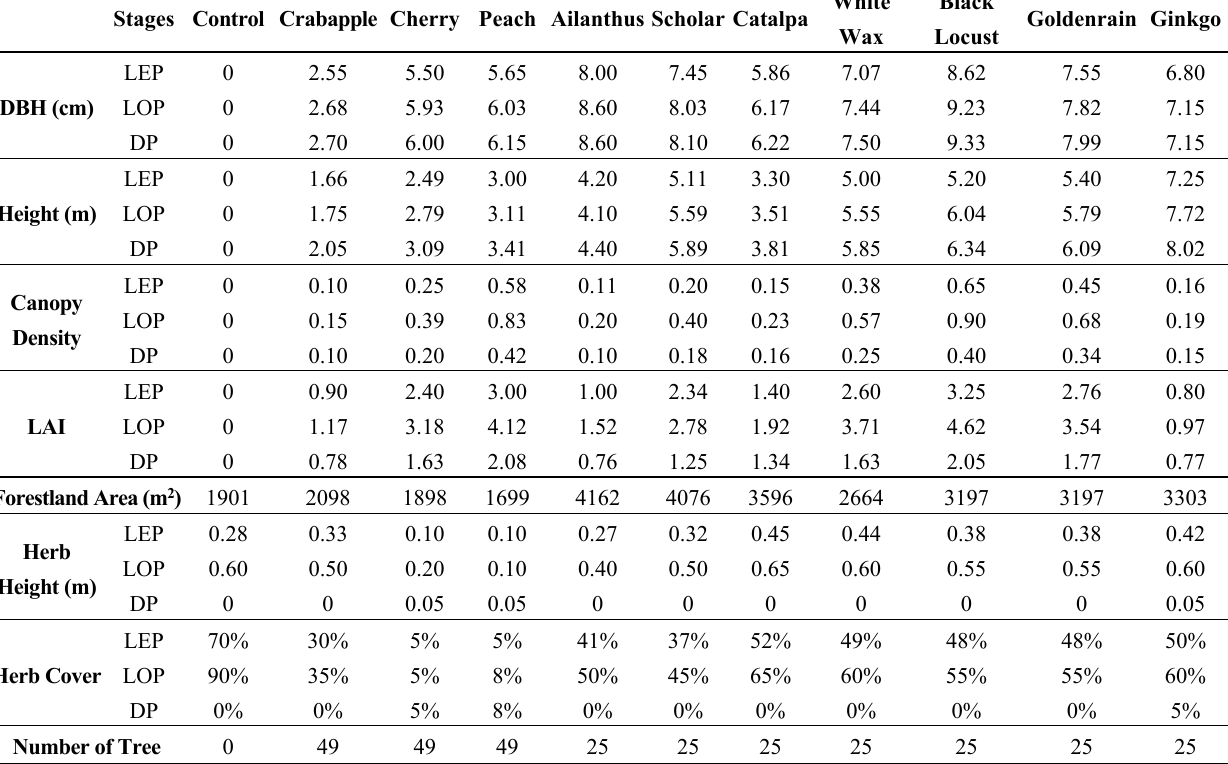
Table 1. Stand structure